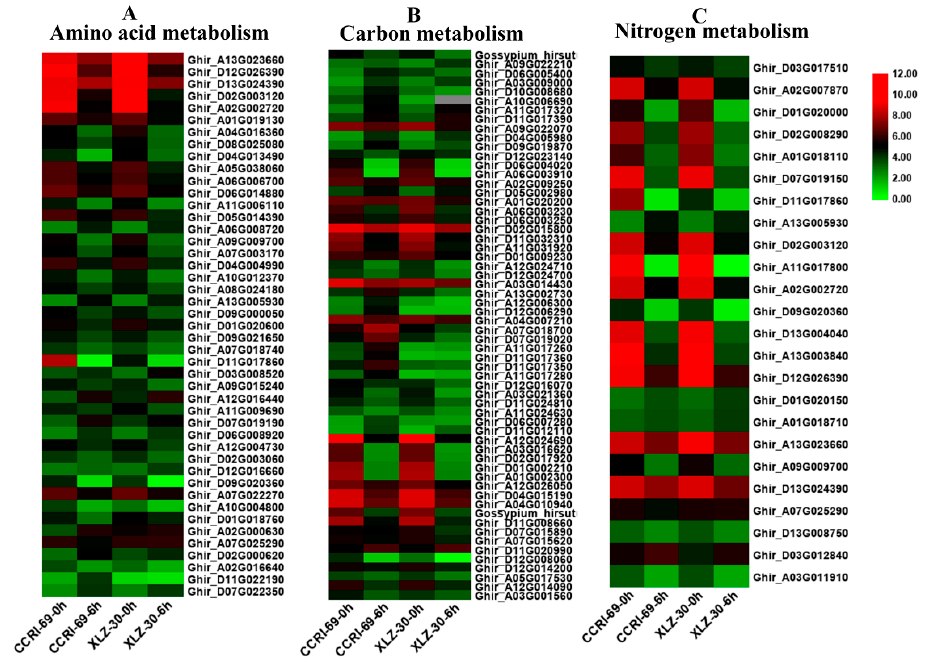
Figure 4. The expression patterns of genes involved in amino acid ( A ), carbon ( B ), and nitrogen ( C ) metabolism in the root of two cotton genotypes. The heat map represents the relative expression levels of genes based on Fragments Per Kilobase Million (FPKM) values using RNA sequencing (RNA-seq) data.